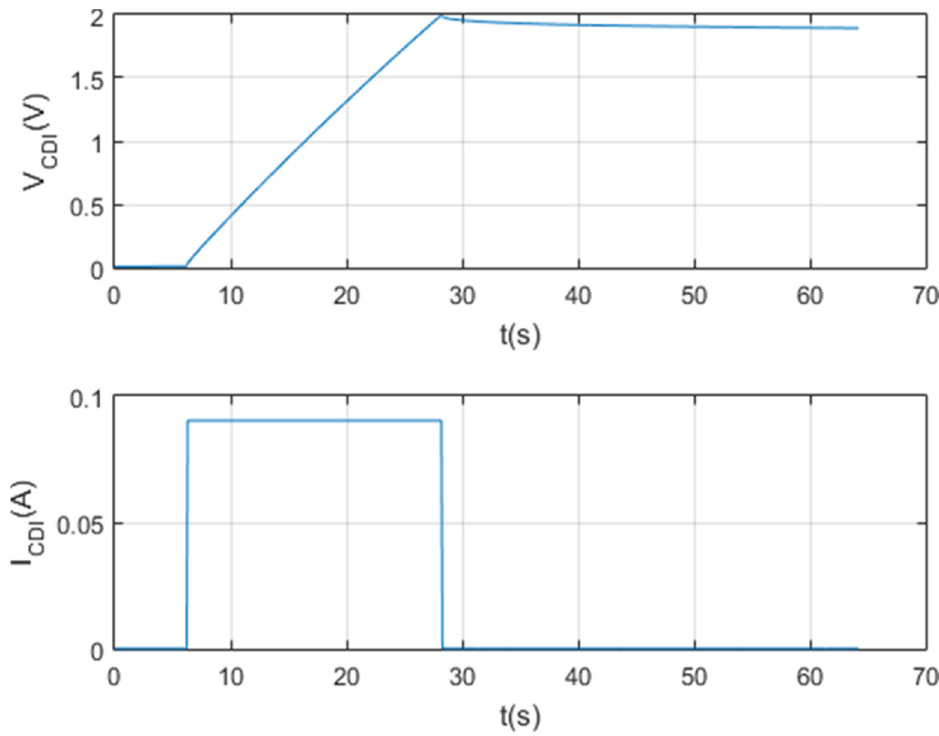
Figure 10. Charge and self-discharge test (voltage–current): Vc_max = 2 V and Ic = 0.1 A.